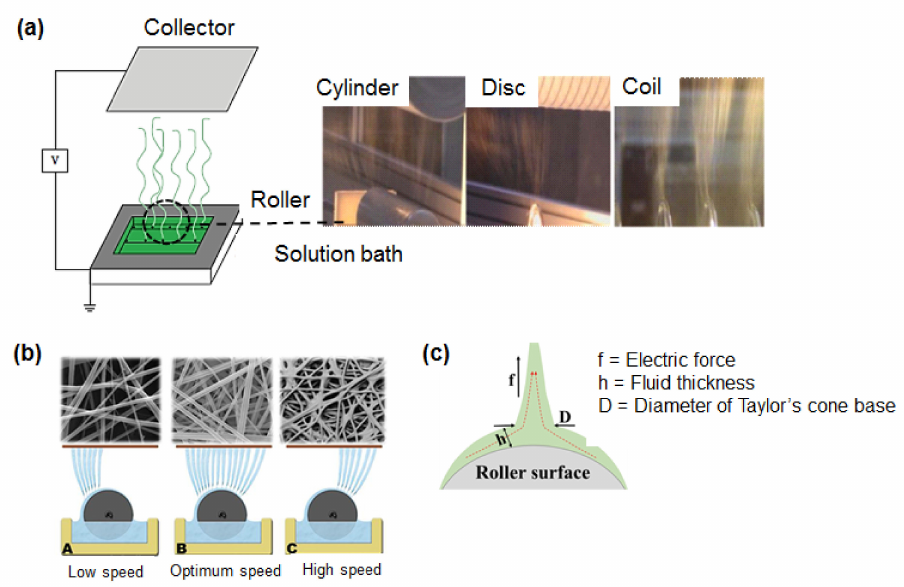
Figure 3. ( a ) Illustration of a needle-free electrospinning system. ( b ) Effect of the roller speed on the quality of a nanofiber web. ( c ) Schematic diagram of a Taylor’s cone on a roller surface. Figure is adapted and modified from